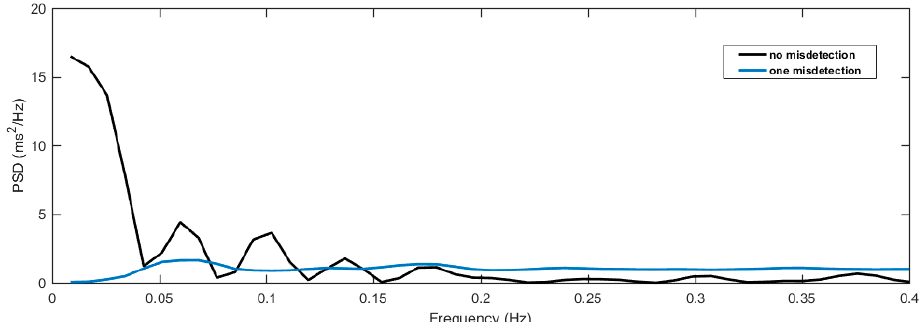
Figure 8. A single misdetection of the R peak results in wrong NN intervals, which can greatly modify the result of the frequency analysis of the HRV as compared to the actual analysis without misdetection.